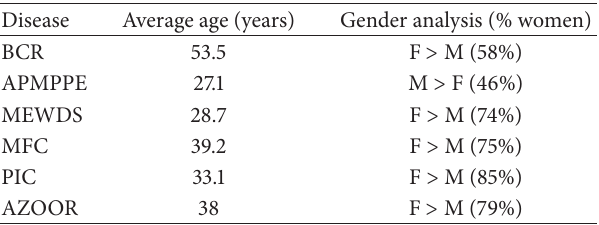
Table 7: Summary of gathered